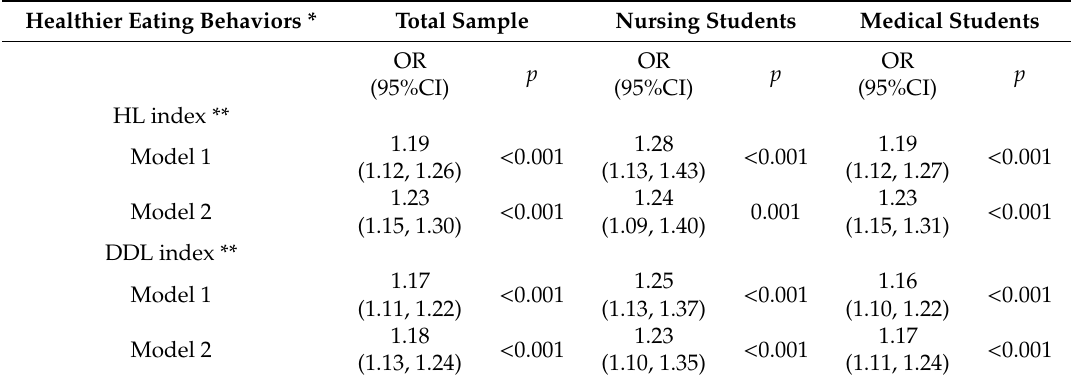
Table 4. Associations of health literacy and digital healthy diet literacy with eating behavior changes ( N = 7616). Healthier Eating Behaviors